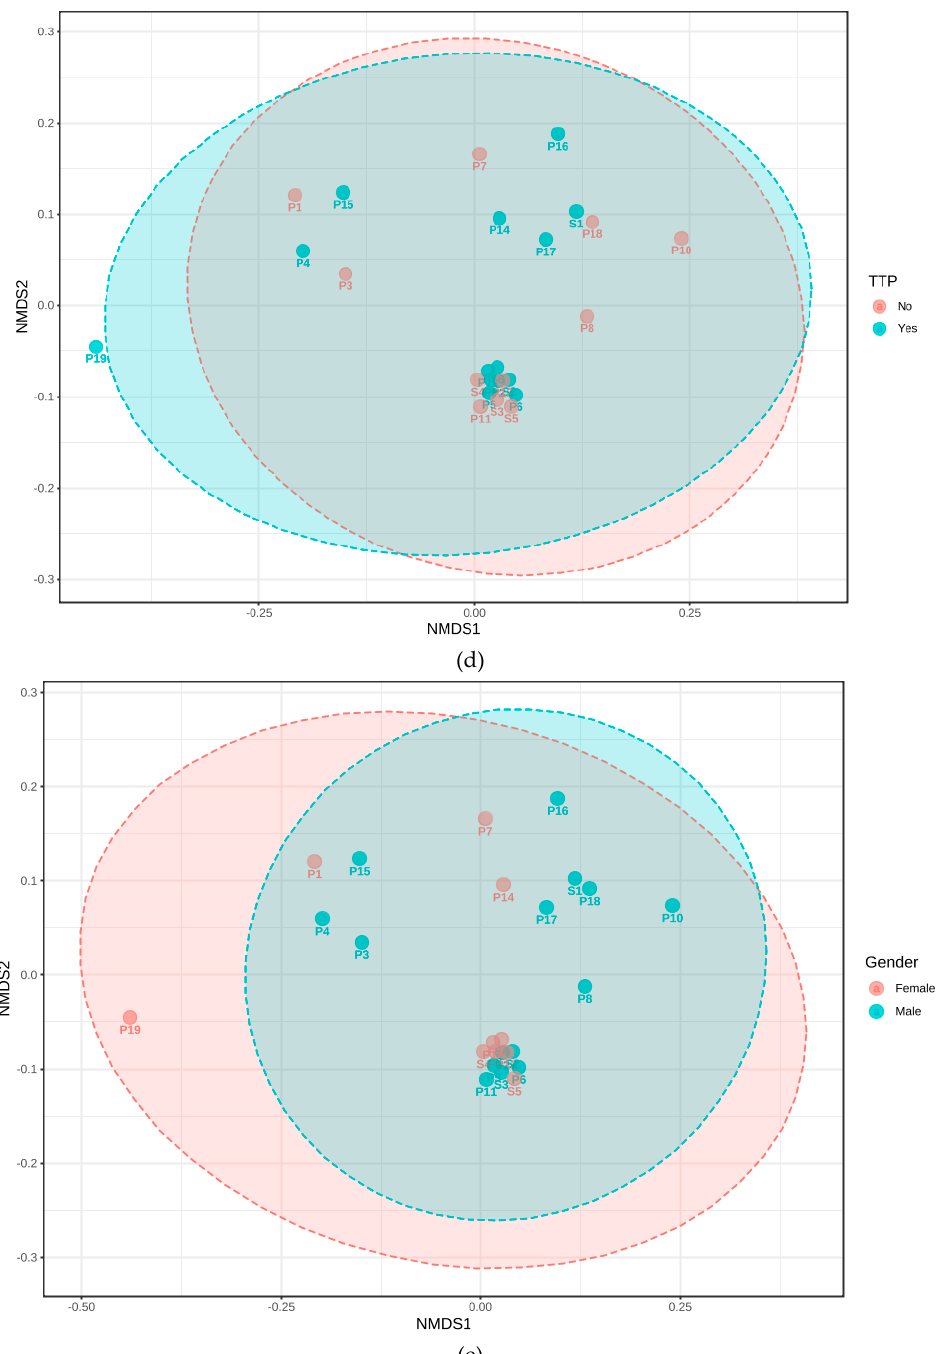
Figure 5. a–e: Multidimensional scaling analysisesof microbiomal diversity, correlated to clinical parameters, displaying the effect on dispersion by sample number at genus level for metadata analysed, based on infection types ( a ), presence of sinus tracts ( b ), pain ( c ), tenderness to percussion ( d ) and gender ( e ). The cluster analysis demonstrated significant clustering by PERMDISP for infection type ( p < 0.01) and the presence of sinus tract ( p < 0.01). A more condensed clustering, covering secondary cases was noted. NMDS—non-metric multidimensional scaling